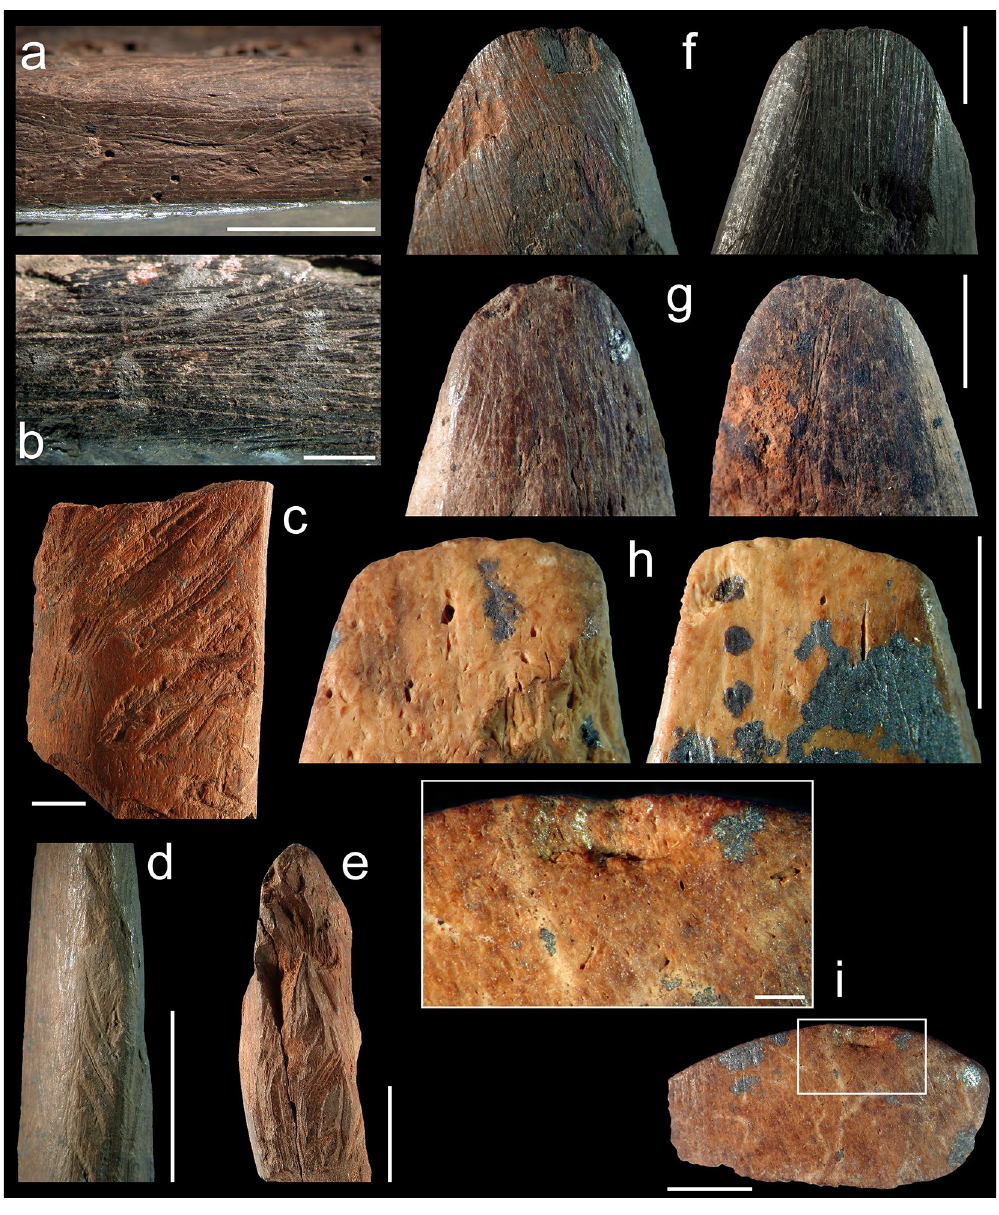
Figure 3. Traces of manufacture and use-wear. The manufacture of the double-beveled bone tools from Sibudu entailed scraping the lateral edges ( a – b ), vigorously gouging the flat and lateral sides of the object ( c – e ), and shaping the tip by scraping ( f – g ). Use-wear takes the form of polish extending over the flat face of the bevel ( g – h ) as well as micro-removal scars with polished edges ( i ). Scales: ( b ) = 1 mm; ( a , c – d , f – i ) = 5 mm; ( e ) = 1 cm. Photographs by